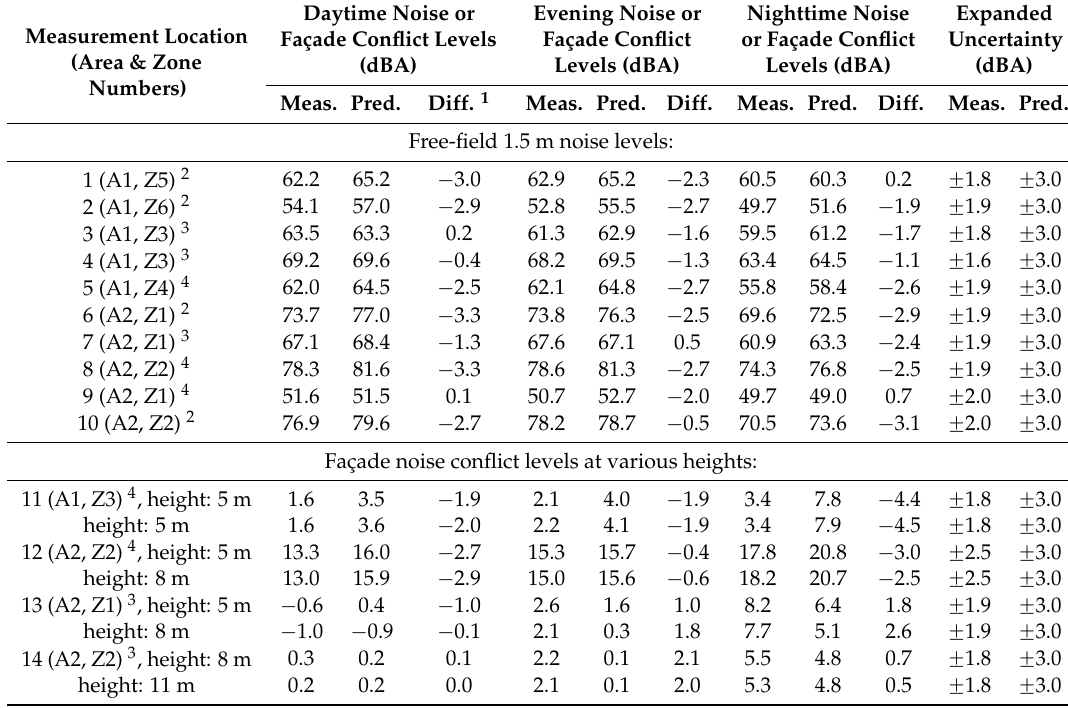
Table 7. Comparison of predicted and measured noise